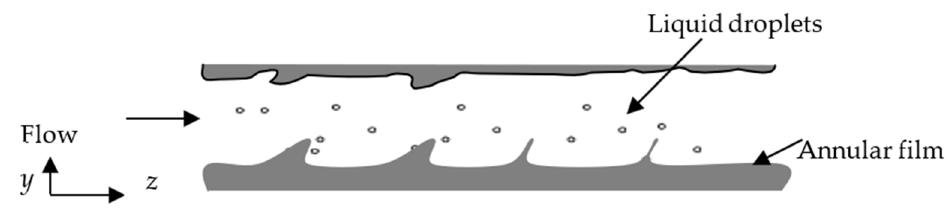
Figure 1. A schematic view of annular flow patterns in a cross-section of a horizontal